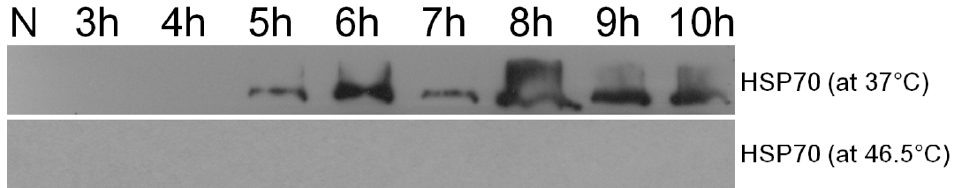
Figure 4. Western blotting analysis of the HSP70 in heat-treated Scenedesmus cells. Cells (1 × 10 7 ) were either subjected to 37 °C treatment for various times (upper panel) or 46.5 °C for one hour then cultivated at 32 °C for various time (lower panel). N, normal cell.